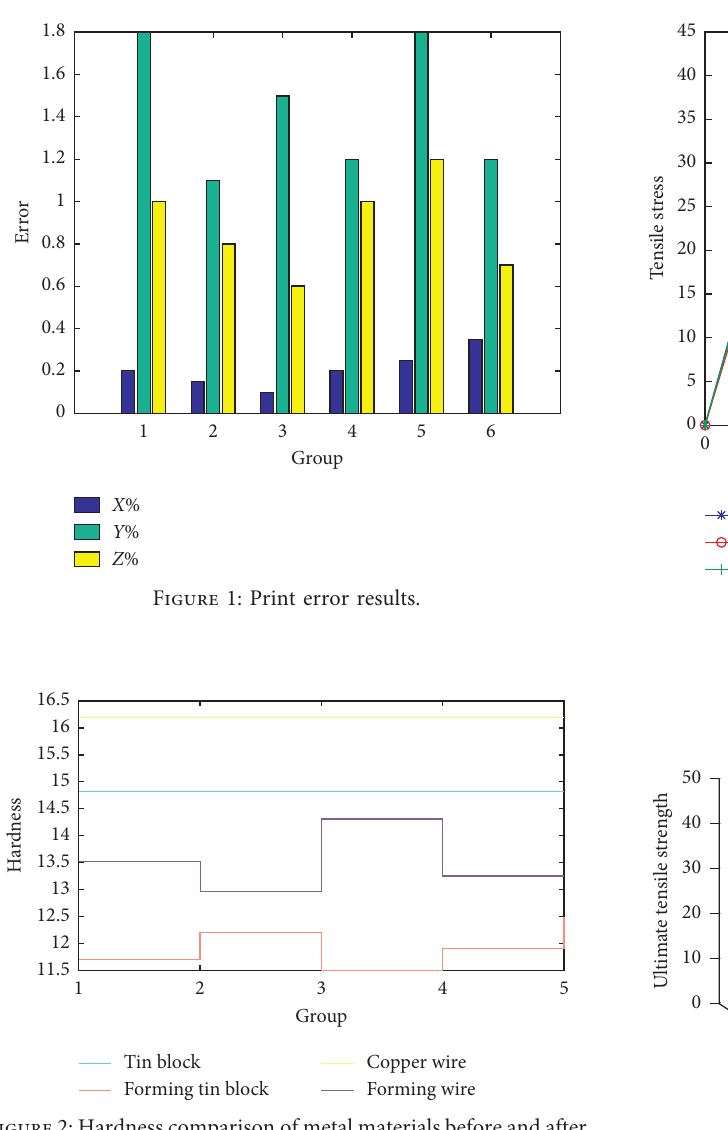
Figure 2: Hardness comparison of metal materials before and after